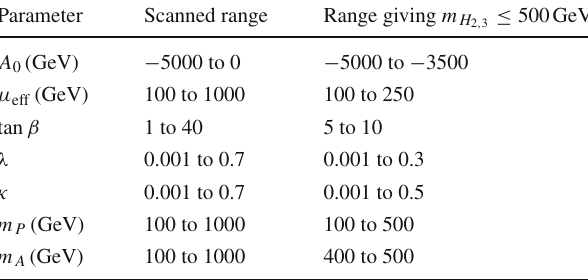
Table1 RangesoftheNMSSMinputparametersscannedforobtaining H 2 and H 3 with large mass-degeneracy. The third column shows